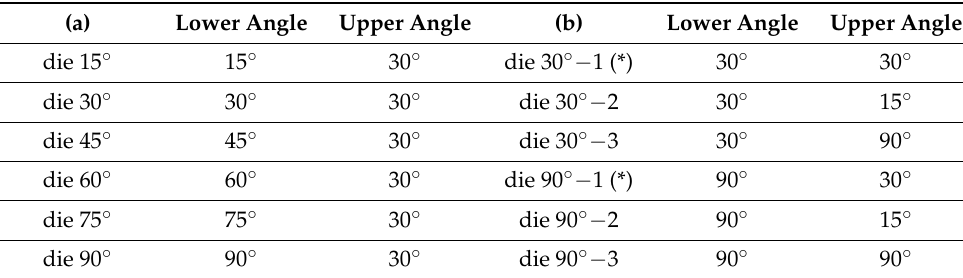
Table 1. Summary of the bridge die geometries used in this research: (a) lower bridge and (b) up- per bridge.